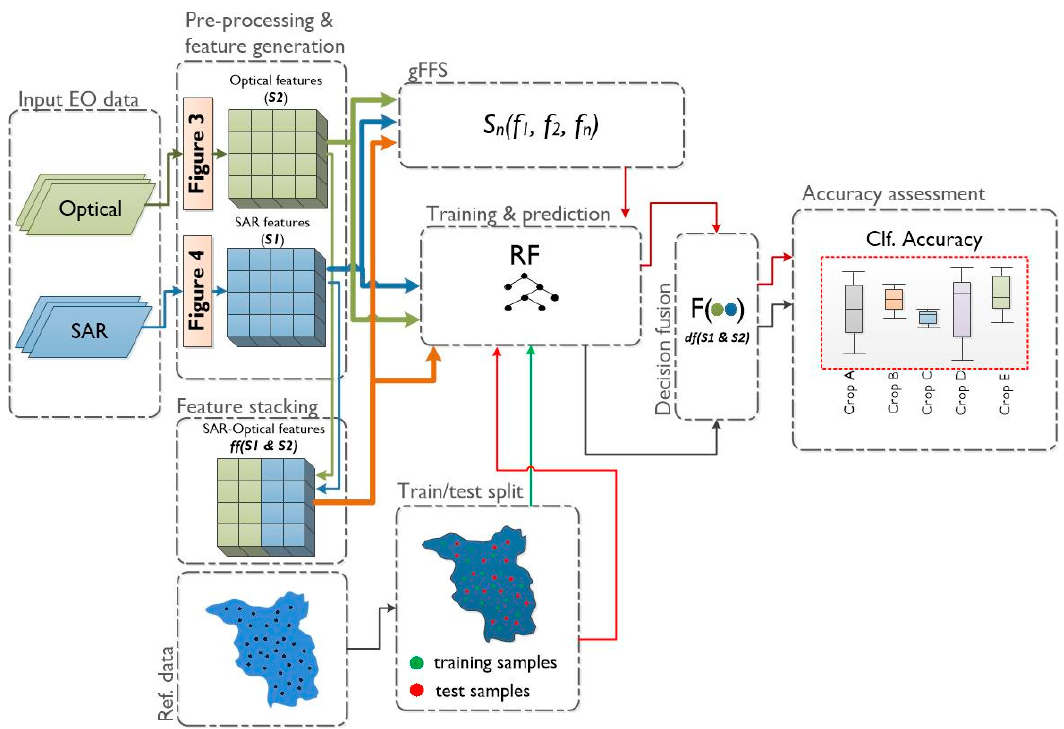
Figure 5. Schematic overview of the methodological workflow.